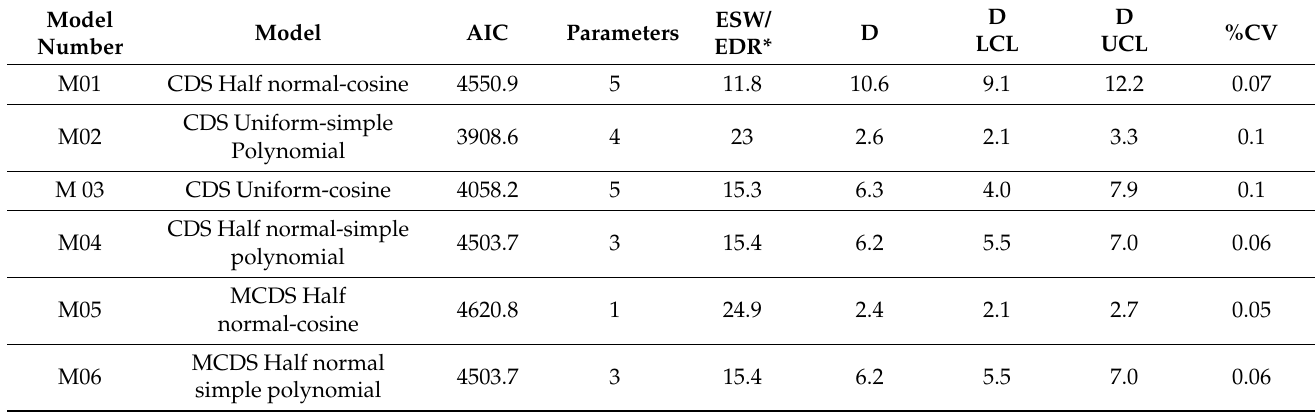
Table 2. Model selection based on estimates of AIC and density (D) for the habitat of Western Tragopan in the study